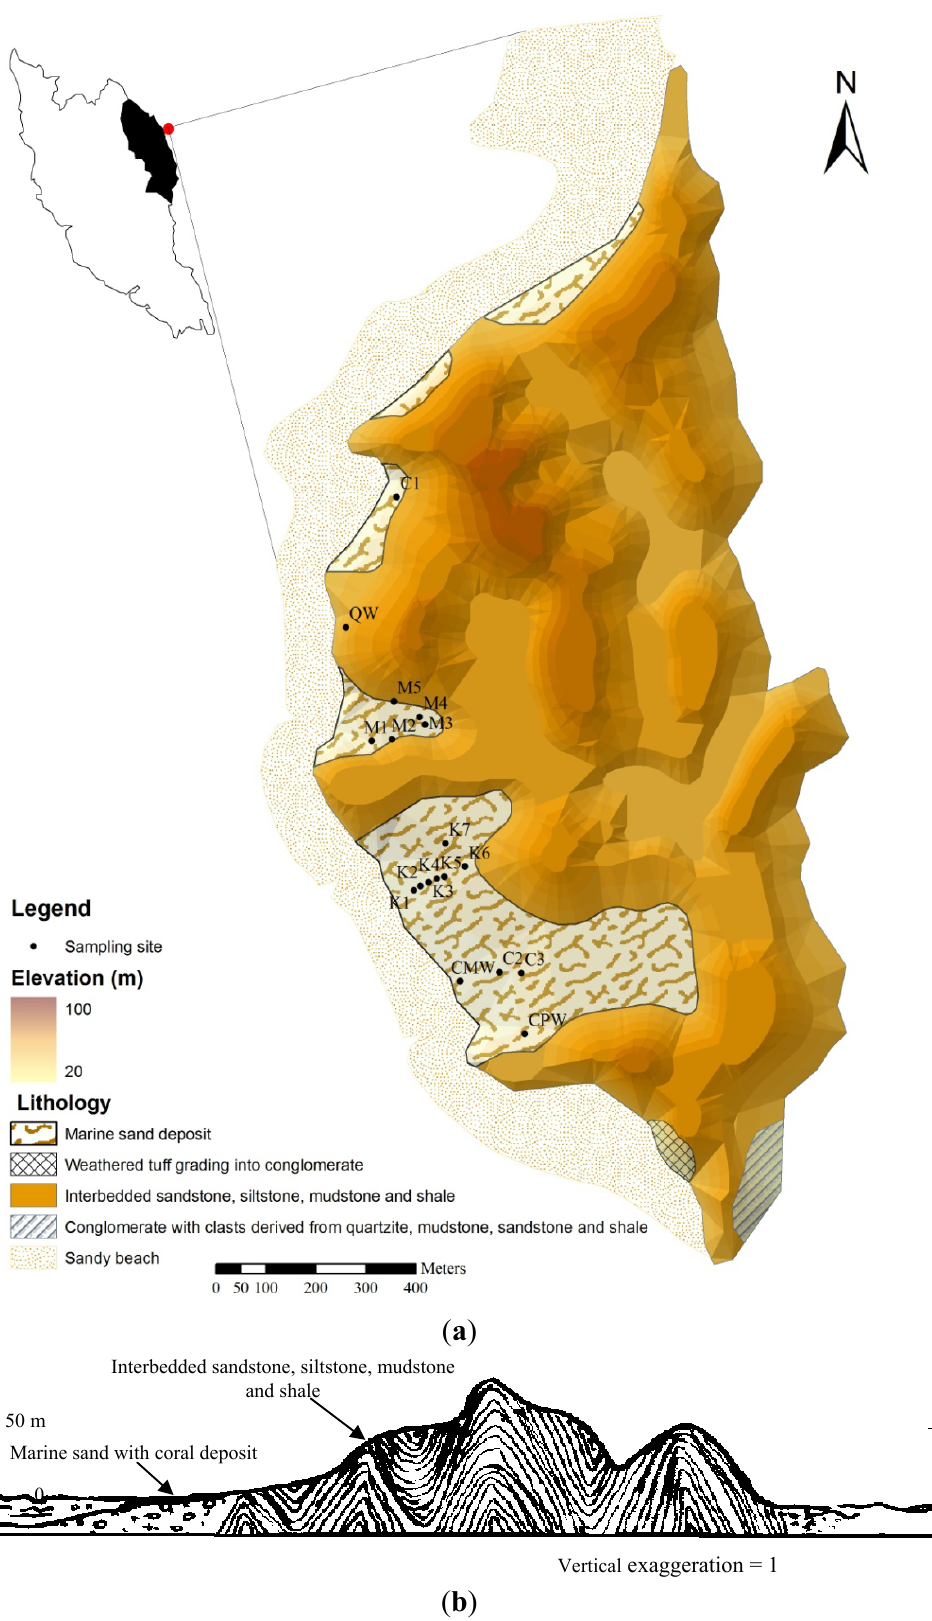
Figure 1. Map of study area showing sampling sites, elevation and lithology of the island ( a ) and ( b ) cross section of the island from west to east. Modified from